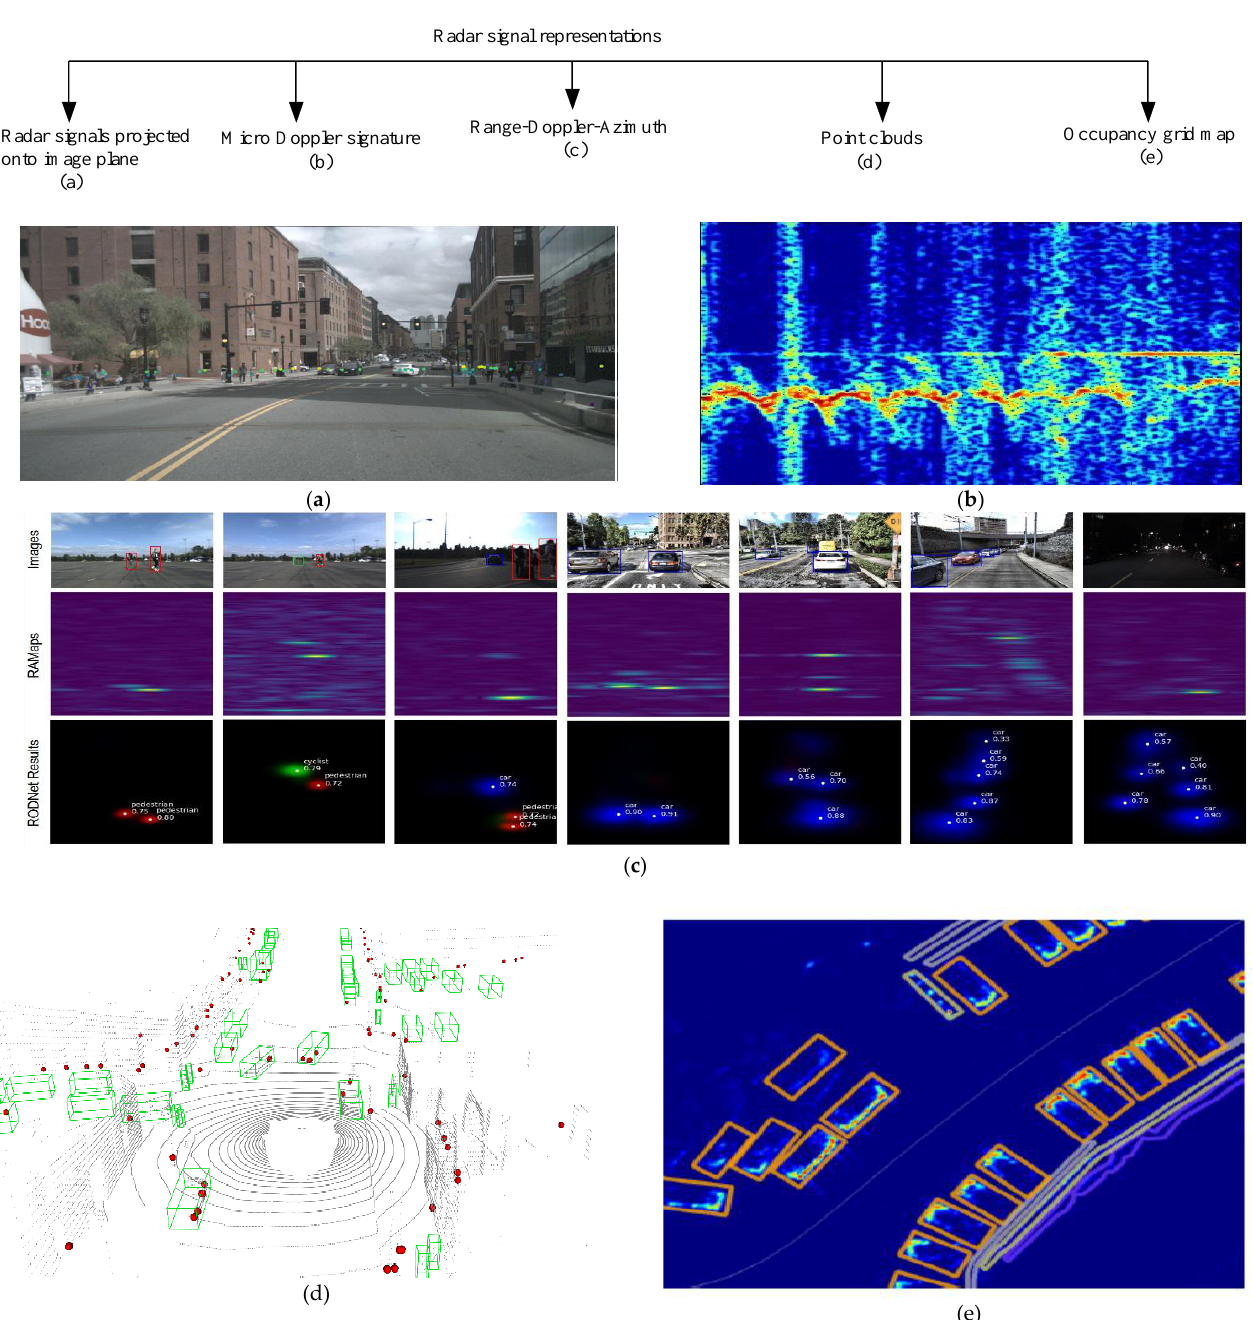
Figure 9. Example of different radar signal format representations. ( a ) Radar point clouds projected onto an image camera plane [58], with different colors depicting the depth information, ( b ) Spectrograms of a person walking away from the FMCW radar. ( c ) Samples of the Range-Doppler-Azimuth (RAMAPs) representations from the CRUW dataset [98], with the first row showing the images from the scene and the second row depicting their equivalent RAMAP tensors (d) Sample of Radar point clouds (red) with 3D annotations (green) and Lidar point clouds (grey) from the Nuscenes dataset. Image from [118]. And, ( e ) Example of a radar occupancy grid from a scene with multiple parked automobiles [119]. The white line represents the test vehicle driving path, and the rectangles represent the manually segmented objects along the grid.